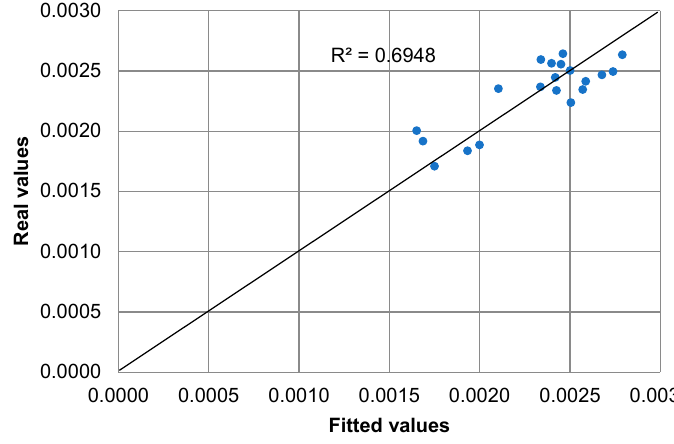
Figure 3. Real values versus estimated values for the three-factor model.